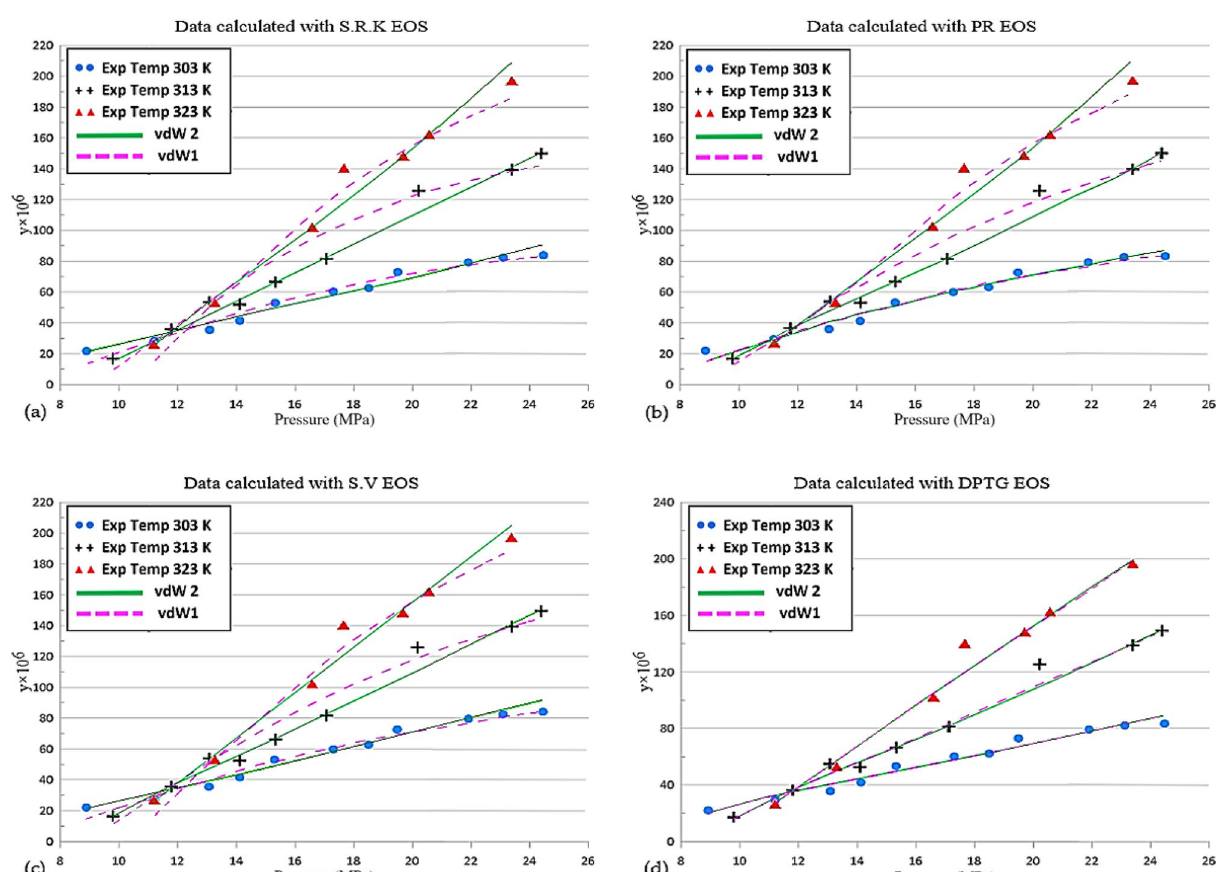
Figure 5. Comparison of experimental data (points) and calculated (line) solubility of vitamin